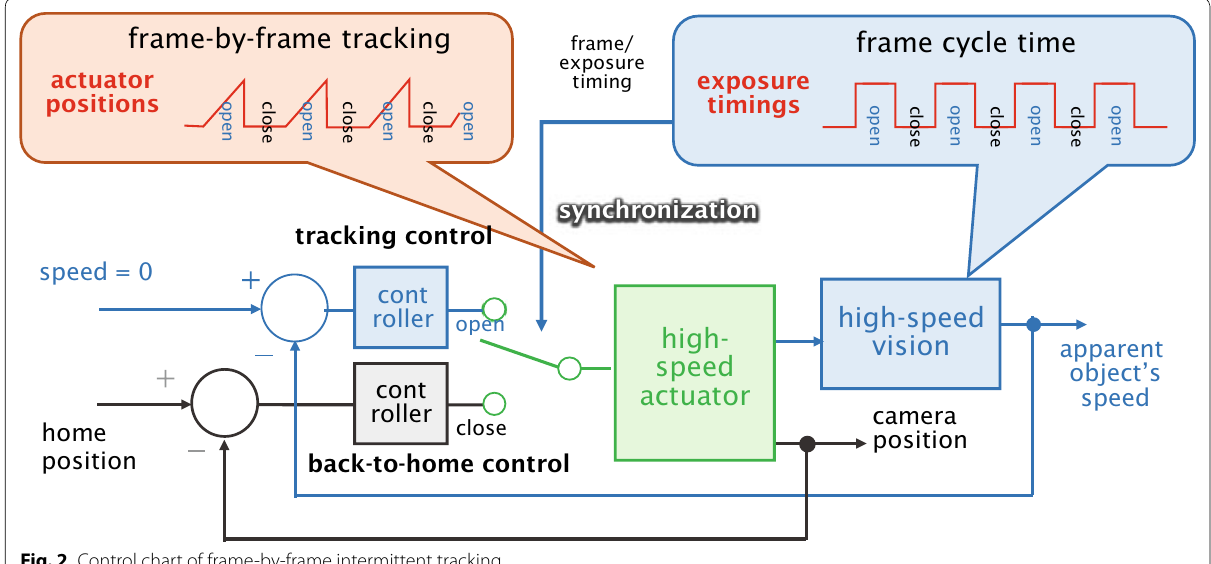
Fig. 2 Control chart of frame-by-frame intermittent